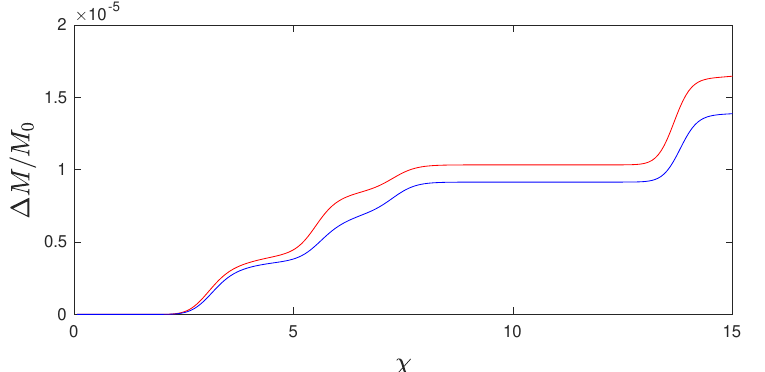
Figure 4. Relative error on M for the same parameter values as in Figure 2. Predictions from our model (blue line) and the spatial form of the classical Dysthe’s equation (red line) are